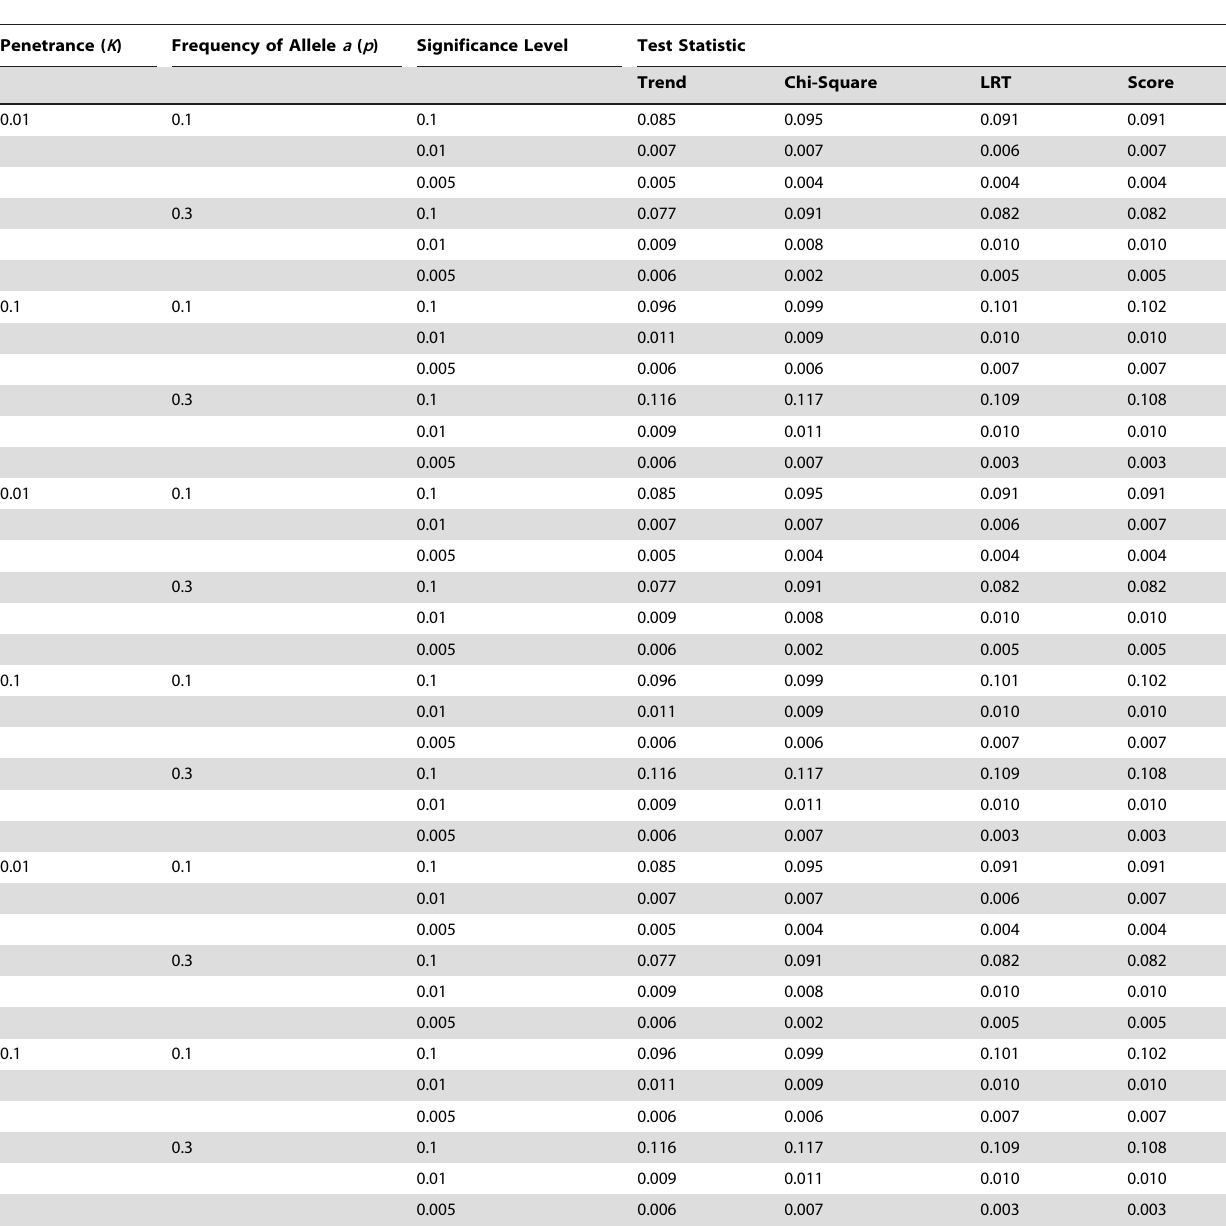
Table 2. Simulated type I error rate in the case of a univariate phenotype under various generating models.